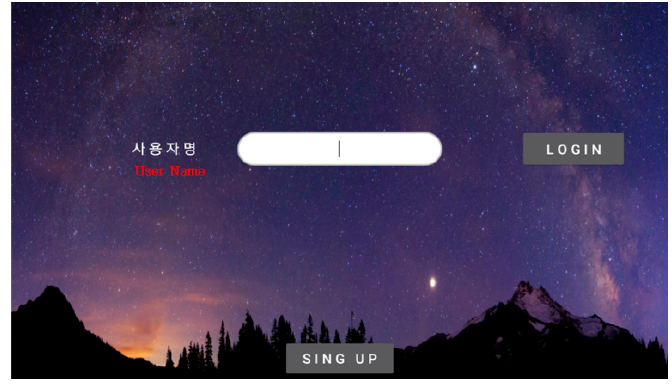
Figure 7. Login screen.